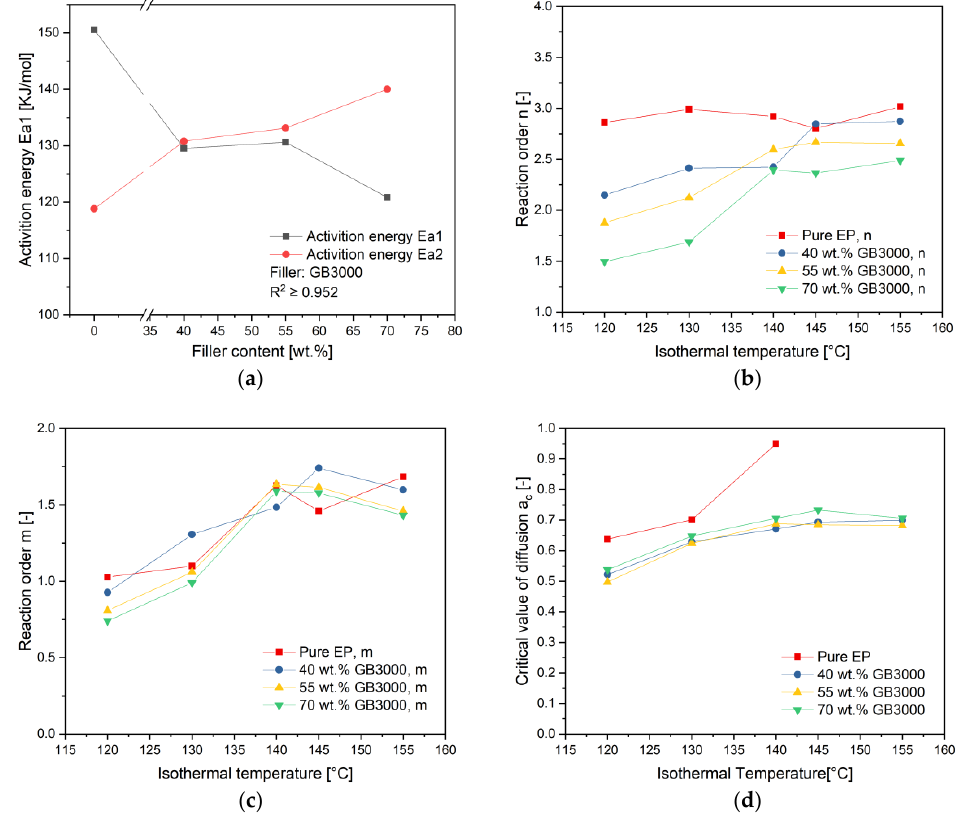
Figure 13. Influence of filler content on ( a ) activation energy ( b ) reaction order n for the n th order reaction ( c ) reaction order m for the autocatalytic reaction ( d ) critical value of diffusion a c.